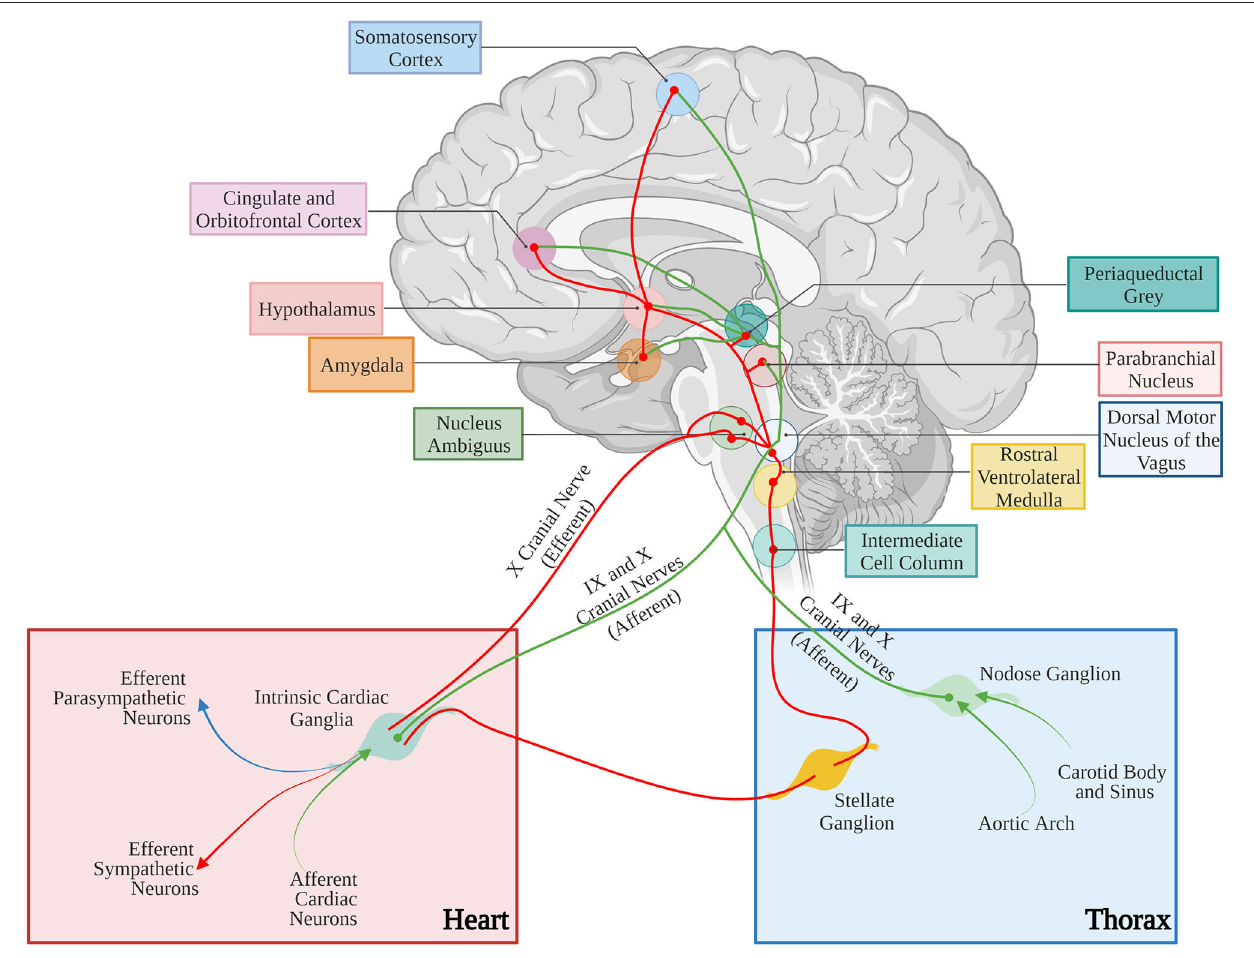
FIGURE 10 | Neural control of the cardiovascular system. Afferent and efferent pathways are shown in green and red lines, respectively. The figure has been simplified to illustrate the major cortical, subcortical, and brain stem areas involved in control of the cardiovascular function. Most areas are interconnected. For anatomic details and physiological effects of the illustrated pathways, please refer to the text and the original article. Adapted with permission from Tahsili-Fahadan and Geocadin (2017) . Adapted from “Anatomy of the Brain,” by BioRender.com (2021). Retrieved from